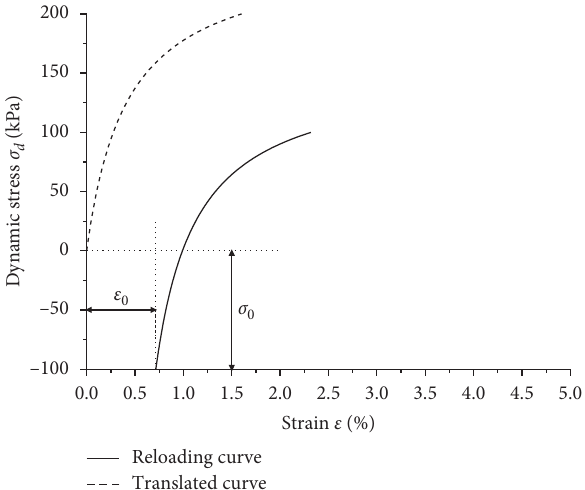
i in the initial loading